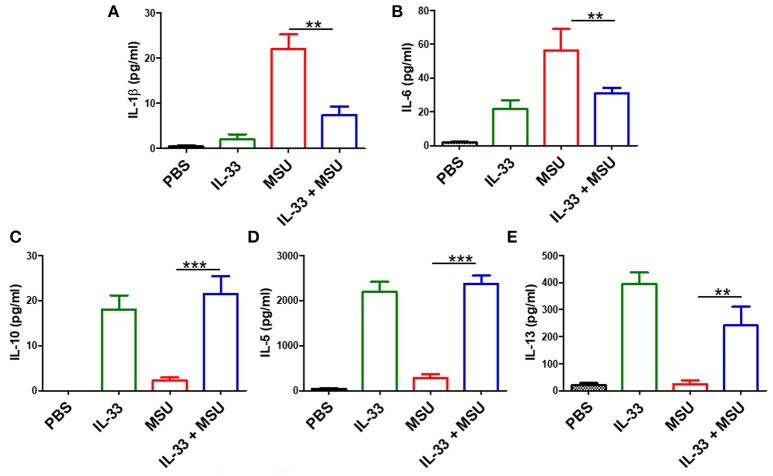
IL-33 administration affects cytokines profile in MSU-induced inflammation. The peritoneal cavity gavage fluids were harvested after MSU treatment 16 h, and performed to detect the IL-1β, IL-6, IL-10, IL-5, and IL-13 cytokines levels by ELISA (A,B). The expression of IL-1β and IL-6 in the MSU-inflammation was decreased by IL-33 treatment (C–E). The expressions of IL-10, IL-5, and IL-13 in mice after IL-33 and MSU pretreatment were also analyzed by ELISA. Data are shown as the mean ± SEM (n = 7/group) and are representative of three independent experiments; **p < 0.001, ***p < 0.0001.